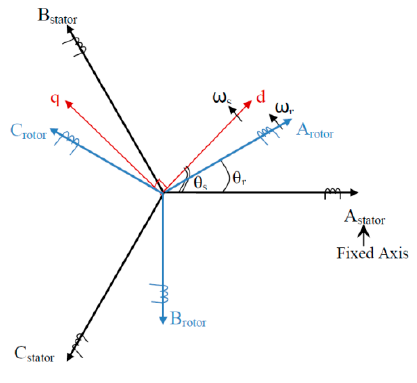
Figure 3. Phasor representation of stator and rotor axes of a DFIG.